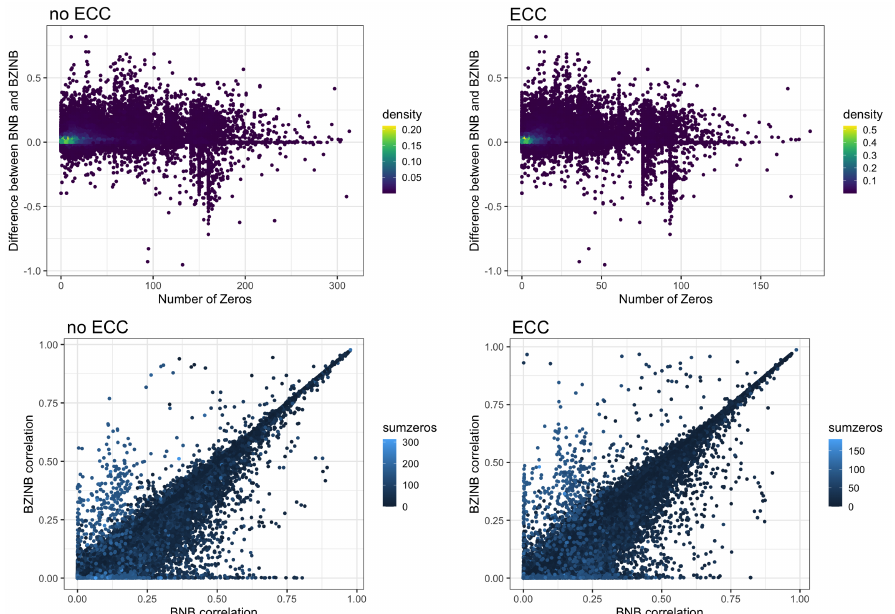
Figure A4. Species-wise (HUMAnN 2.0) numbers of zeros plotted against mean log nonzero counts.